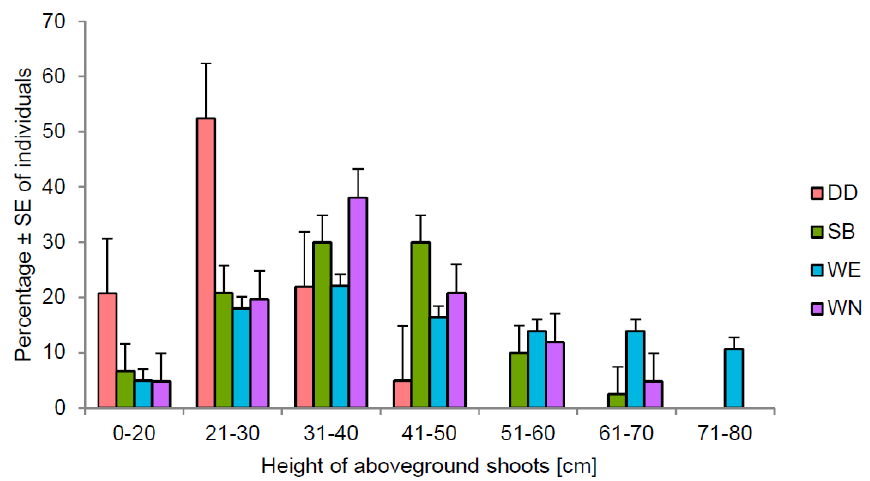
Figure 3. Size structure of Salix lapponum individuals two/three years after the reintroduction treat- ments of the species on different types of habitats. For explanations, see Figure 2.